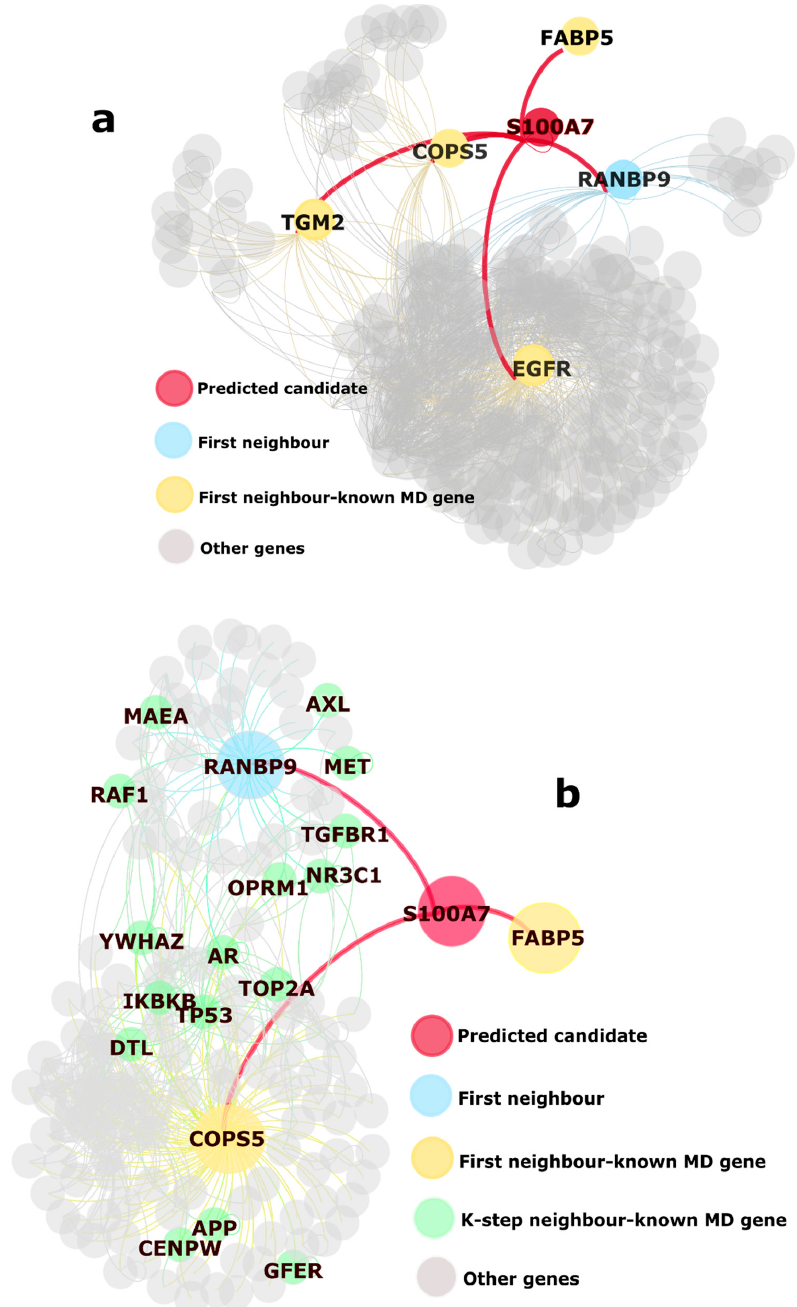
Figure 4. Example of significant gene S100A7 in: ( a ) HPRD and ( b ) BioGRID; In both the networks, S100A7 is connected to known MD genes. In HPRD, it connects some high-degree nodes such as EGFR. In BioGRID, it connects two clusters that have some important, known MD genes. The presence of APP here is notable since pathway analysis for these significant genes highlights Alzheimer’s disease. (Visualization: Gephi).